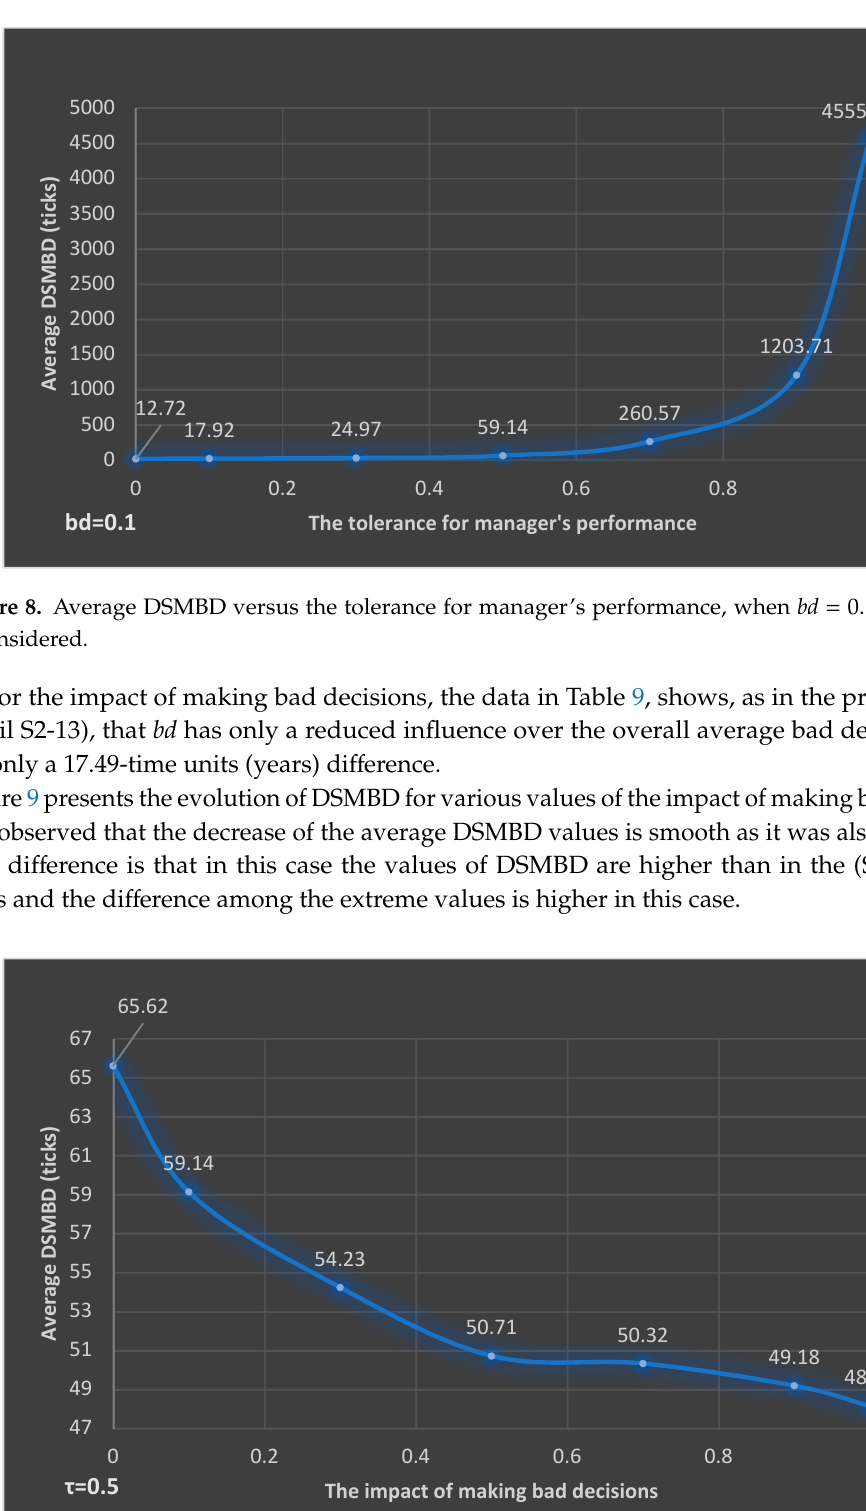
Figure 9. Average DSMBD versus the impact of making bad decisions, when τ = 0.5 and S2 is considered.